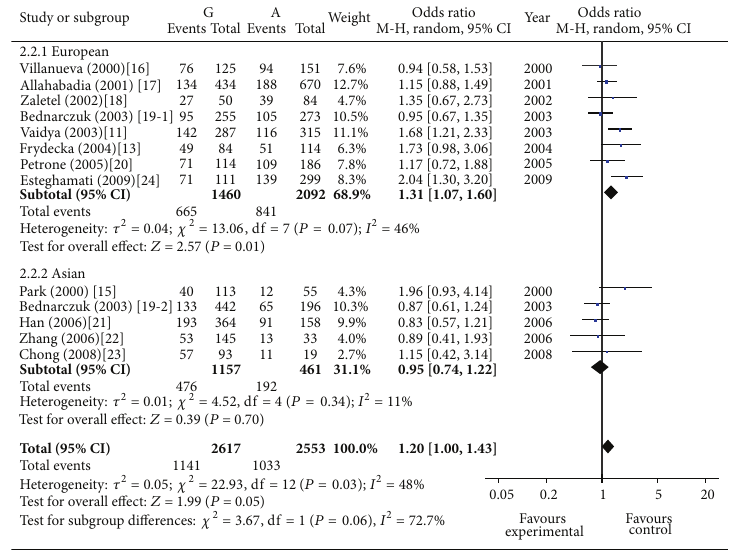
Figure 3: Meta-analysis for the effect of the CTLA4 49A/G allele in G carriers and in A carriers on the risk of GO in GD patients. Each comparison is presented by the name of the first author and the year of publication. The point estimate of the odds ratio and the accompanying 95% confidence interval (CI) are shown. “Total” represents the summary random effects estimation for the comparison along with the respective 95% confidence interval. Values above 1 denote an increased risk for GO with the G